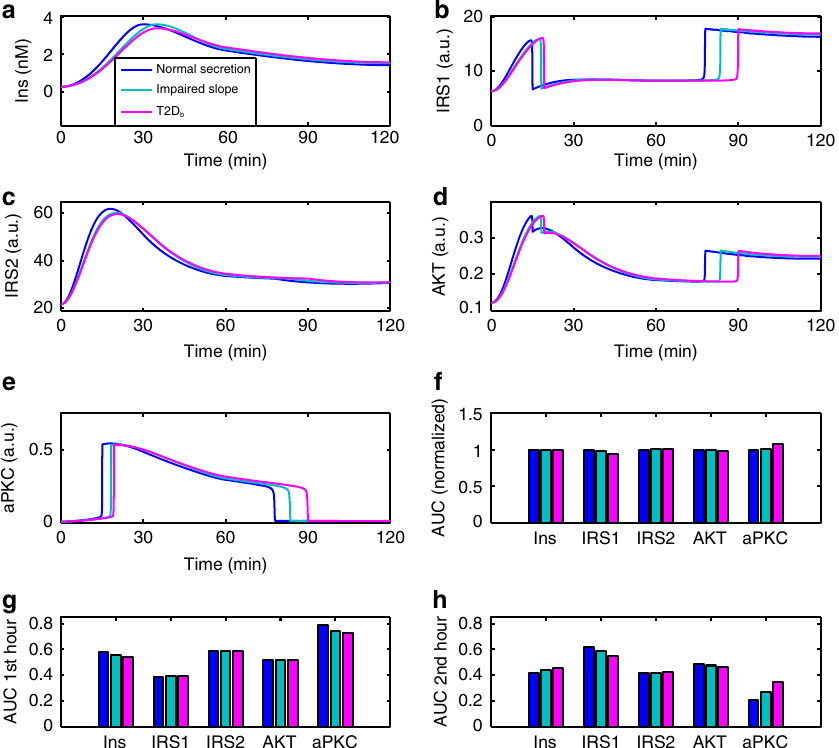
Fig. 5 Response of the model to insulin pro fi les with different dynamic features. Impaired fi rst-phase insulin (cyan) lead to a delayed aPKC switch-off and a delayed IRS1 and AKT rebound. Reduced insulin peak levels (magenta) further delay these activity transitions. See Supplementary Fig. 5 for similar results based on other parameter